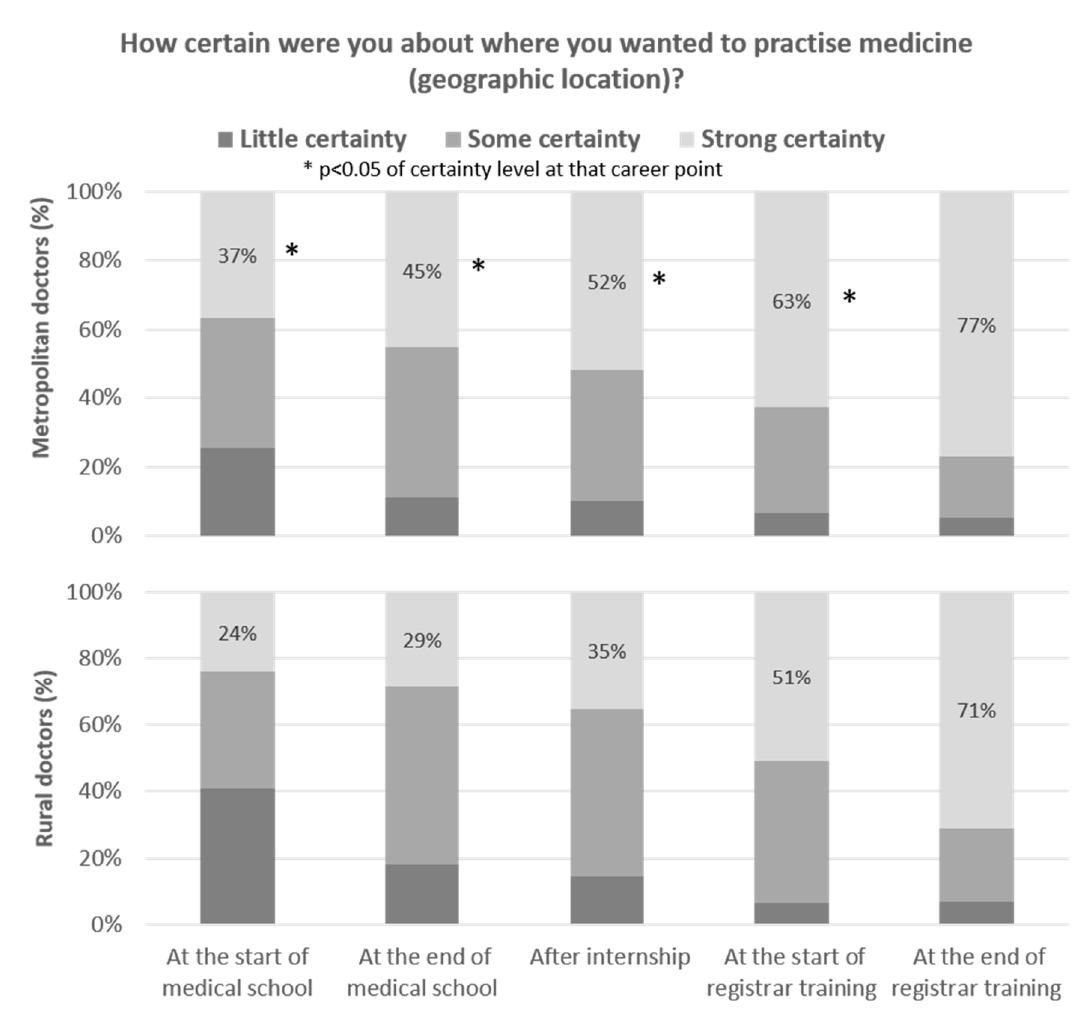
Figure 3. Level of certainty of their practice location decision, by junior doctors’ reflection on five career points.